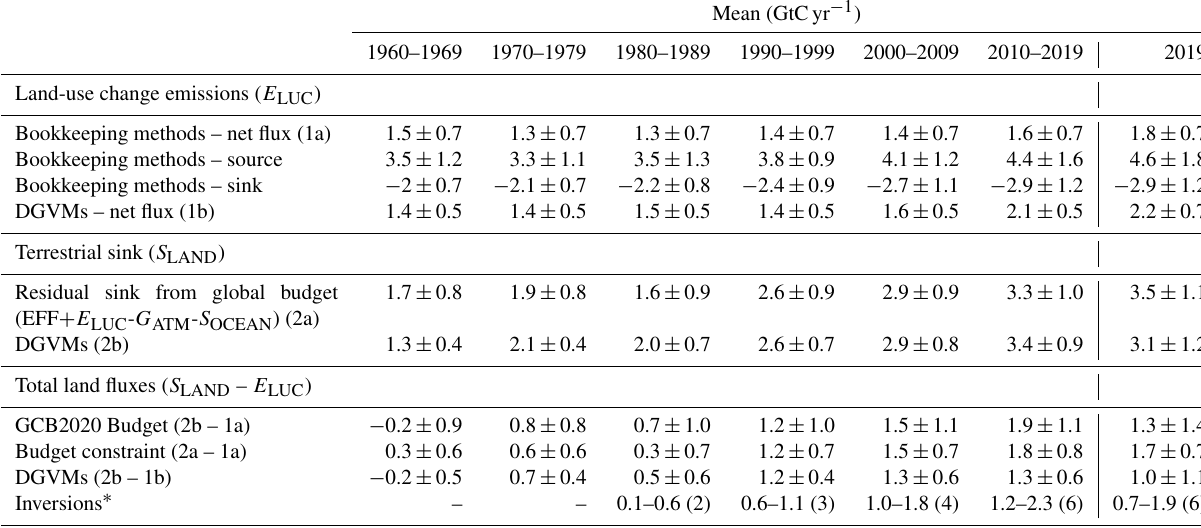
Table 5. Comparison of results from the bookkeeping method and budget residuals with results from the DGVMs and inverse estimates for different periods, the last decade, and the last year available. All values are in GtCyr − 1 . The DGVM uncertainties represent ± 1 σ of the decadal or annual (for 2019 only) estimates from the individual DGVMs: for the inverse models the range of available results is given. All values are rounded to the nearest 0.1GtC and therefore columns do not necessarily add to